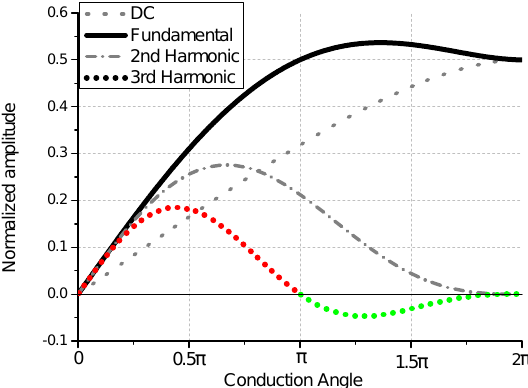
Figure 1. Intrinsic drain current harmonic stimulated by sinusoidal excitation. DC = Direct Current.